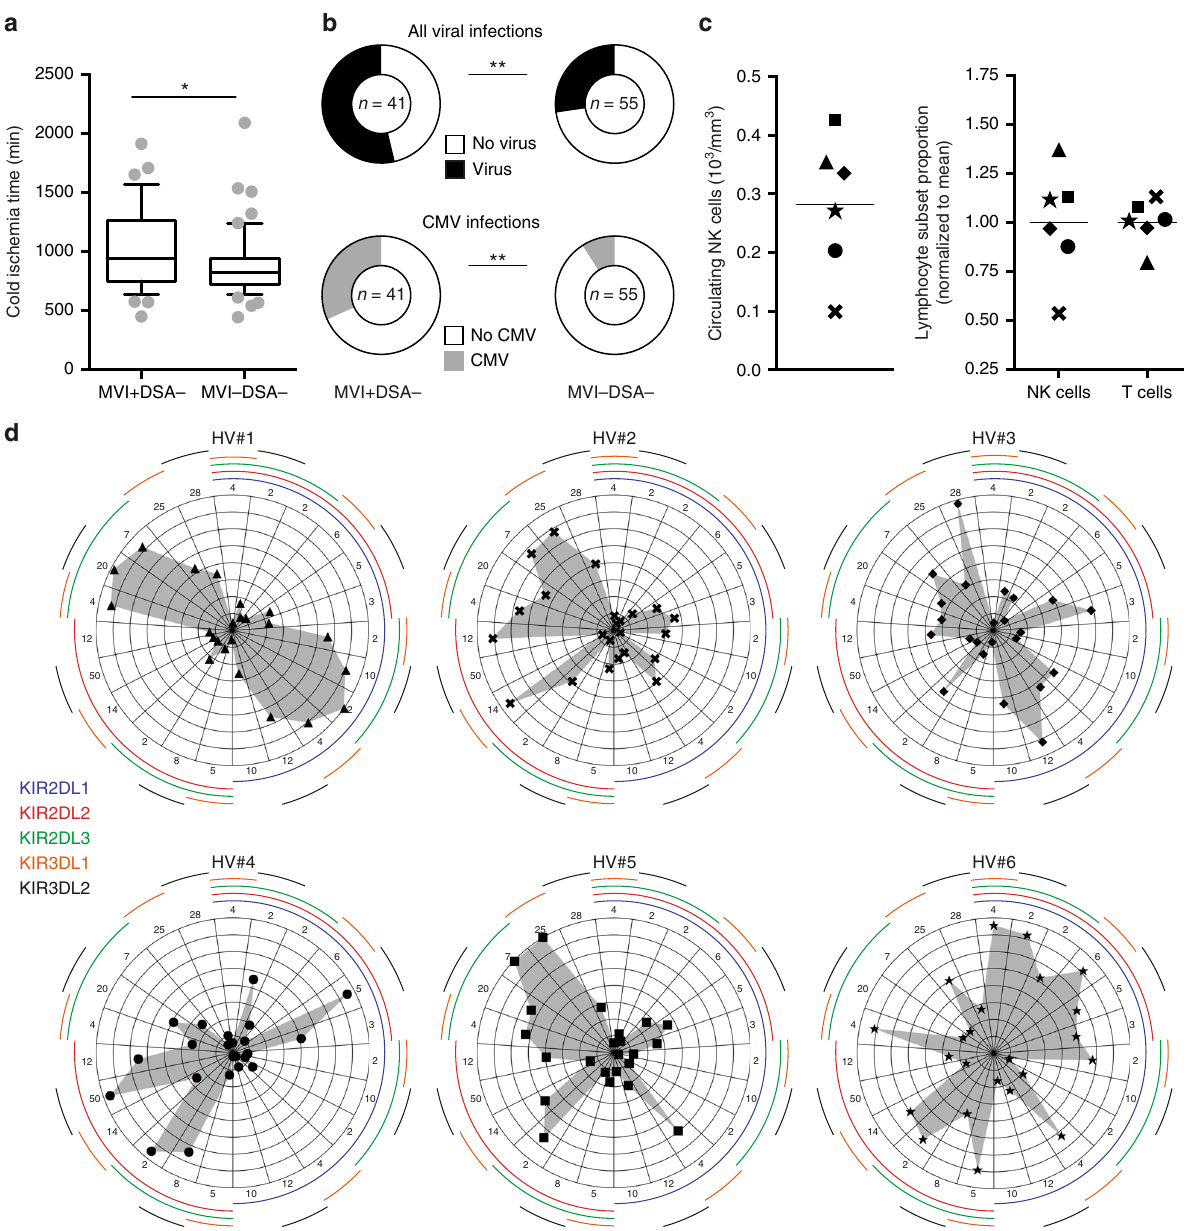
Fig. 3 In fl uence of priming and heterogeneity of the NK cell population. a Cold ischaemia time was compared for patients from the MVI + DSA − and MVI − DSA group. The centre line in the boxes shows the medians; the box limits indicate the 25th and 75th percentiles, the whiskers indicate the 10th and 90th percentiles. * p < 0.05; Mann – Whitney test. b The prevalence of viral (all viruses, upper row) and cytomegalovirus (CMV, lower row) infections were compared for patients from MVI + DSA − (left column) and MVI − DSA − (right column) groups. * p < 0.05; ** p < 0.01; Fisher ’ s exact test. c , d Phenotypic analyses of circulating NK cells from six healthy volunteers (HV #1 to #6) with identical inhibitory KIR genotypes. c Left panel: individual values for absolute count of circulating NK cells are plotted. Right panel: the dispersion of the size of NK and T lymphocyte populations in the circulation of the 6 HV is shown. d Expression of the fi ve inhibitory KIRs was assessed at the single cell level. The differences in distribution of the 23 NK cell subsets are shown for the six healthy volunteers. Each axis of the radar plot represents a given combination of inhibitory KIR as indicated by the colour code on the left. The scale of each axis is adjusted to optimise the display of every population of NK cells. Source data are provided as a Source Data fi